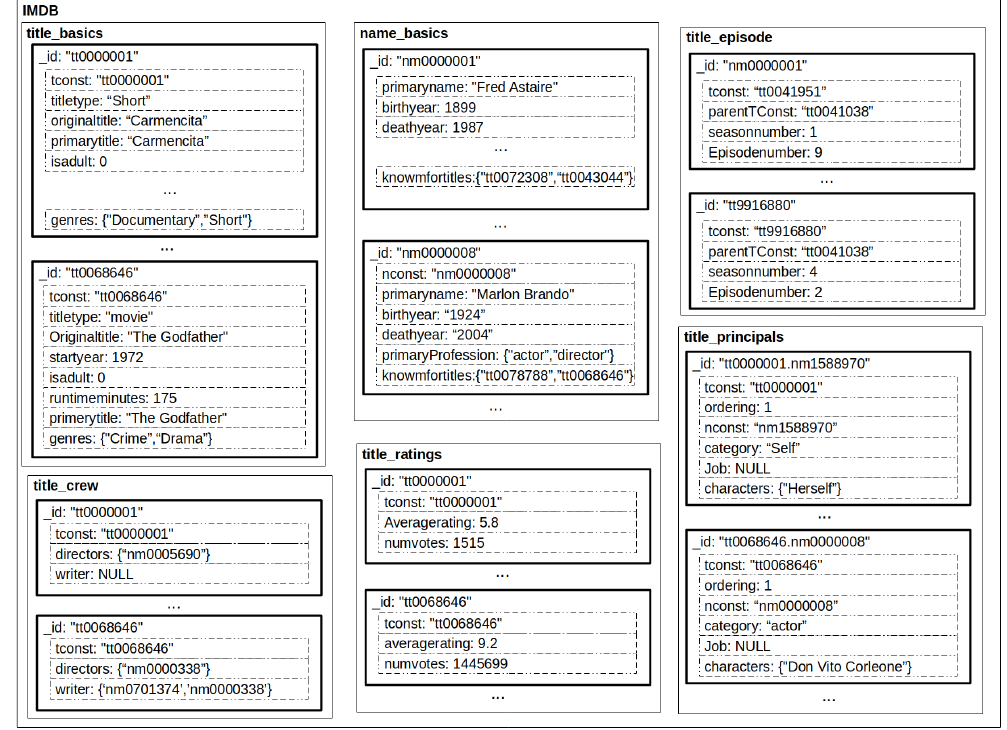
Figure 8. IMDb mapped to MongoDB by the SQLToKyeNoSQL